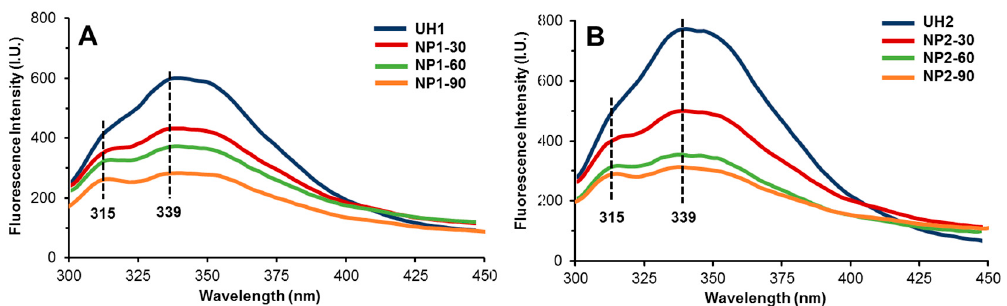
Figure 3. Intrinsic fluorescence property of compared nanoparticles prepared with different amount oxidized dextran, i.e., 1 mg/mL ( A ) and 2 mg/mL ( B ).